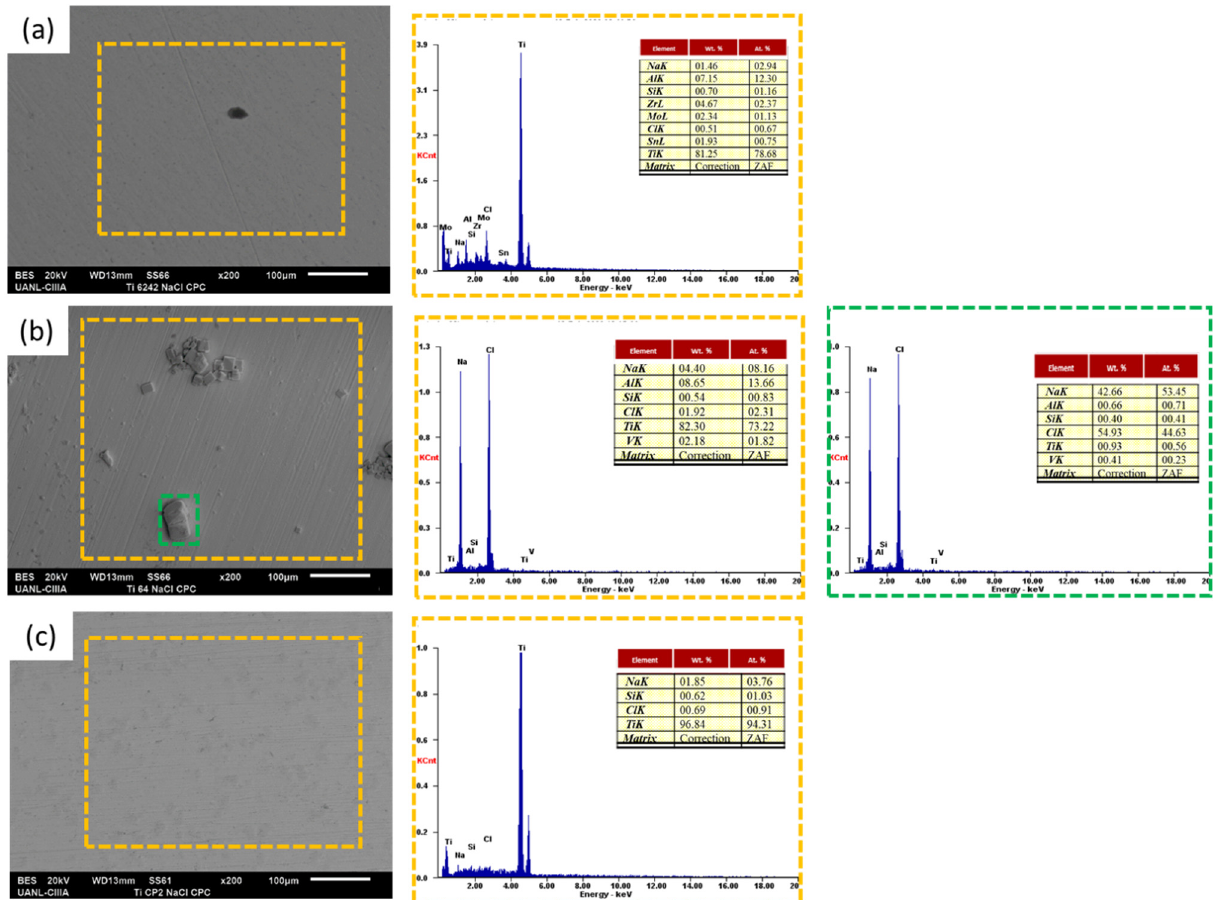
Figure 7. SEM-EDS surface morphology micrographs and EDS spectrum of titanium alloys exposed in a 3.5 wt % in NaCl solution, ( a ) Ti-6Al-2Sn-4Zr-2Mo, ( b ) Ti-6Al-4V, and ( c ) Ti CP2.